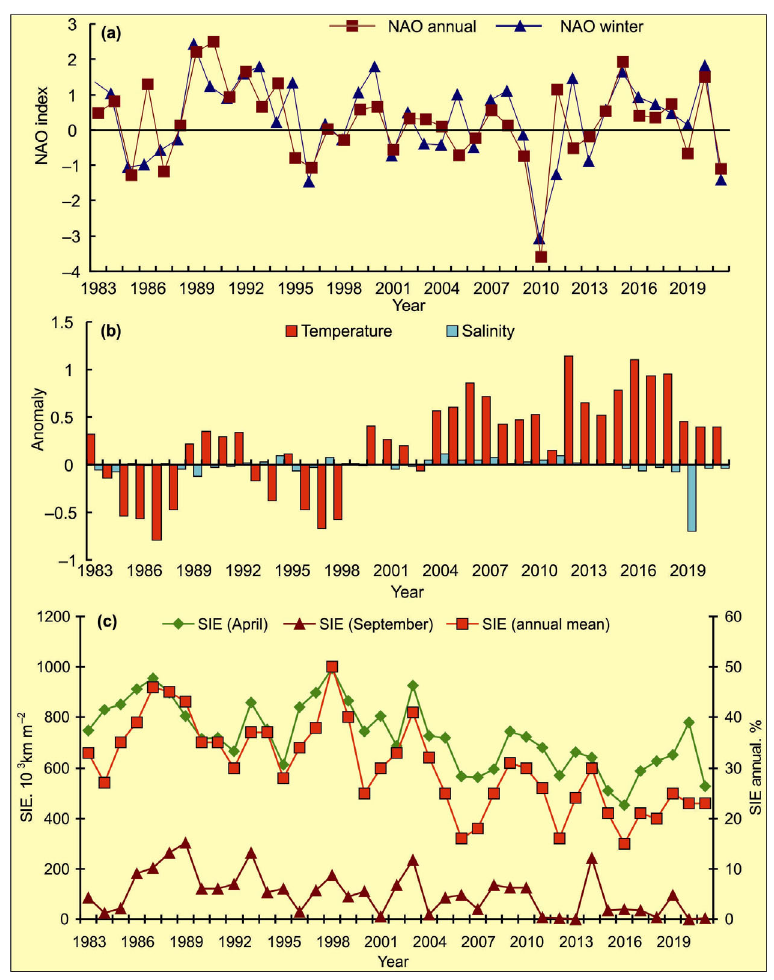
Figure 3. Variations in the climatic indices in 1983–2021. ( a )—annual and winter (DJF) NAO indices in 1984–2021 [53]. ( b )—annual temperature and salinity anomalies in the 0–200 m layer at the Kola Section. St. 3–7—Murman Current [15,16]; ( c )—sea ice extent (SIE) in April and September,